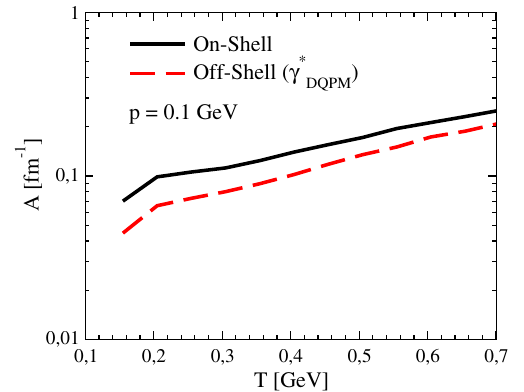
Fig. 4 Ratio between drag coefficient ( A ) and energy density ( (cid:7) ) as function of temperature for two different HQ momentum p = 0 . 1 GeV and p = 5 GeV. Black solid and red dashed line respectively for on- shell and off-shell for p = 0 . 1 GeV while full black circles and open red circles respectively for on-shell and off-shell for p = 5 GeV